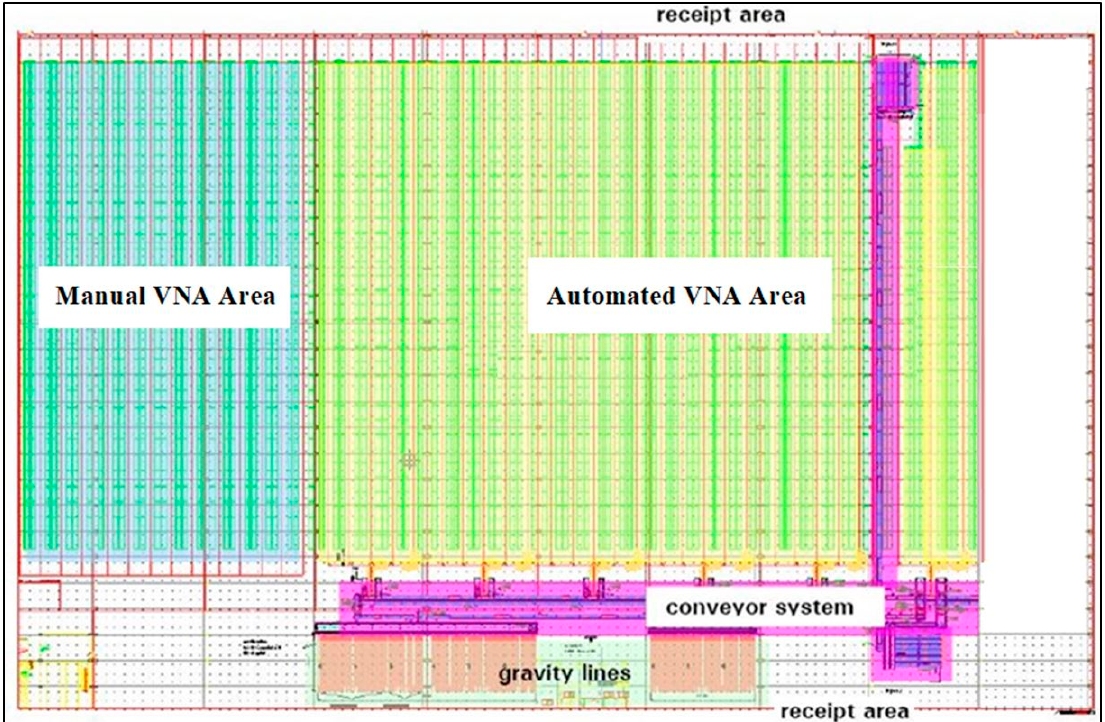
Figure 1. Plant general layout.